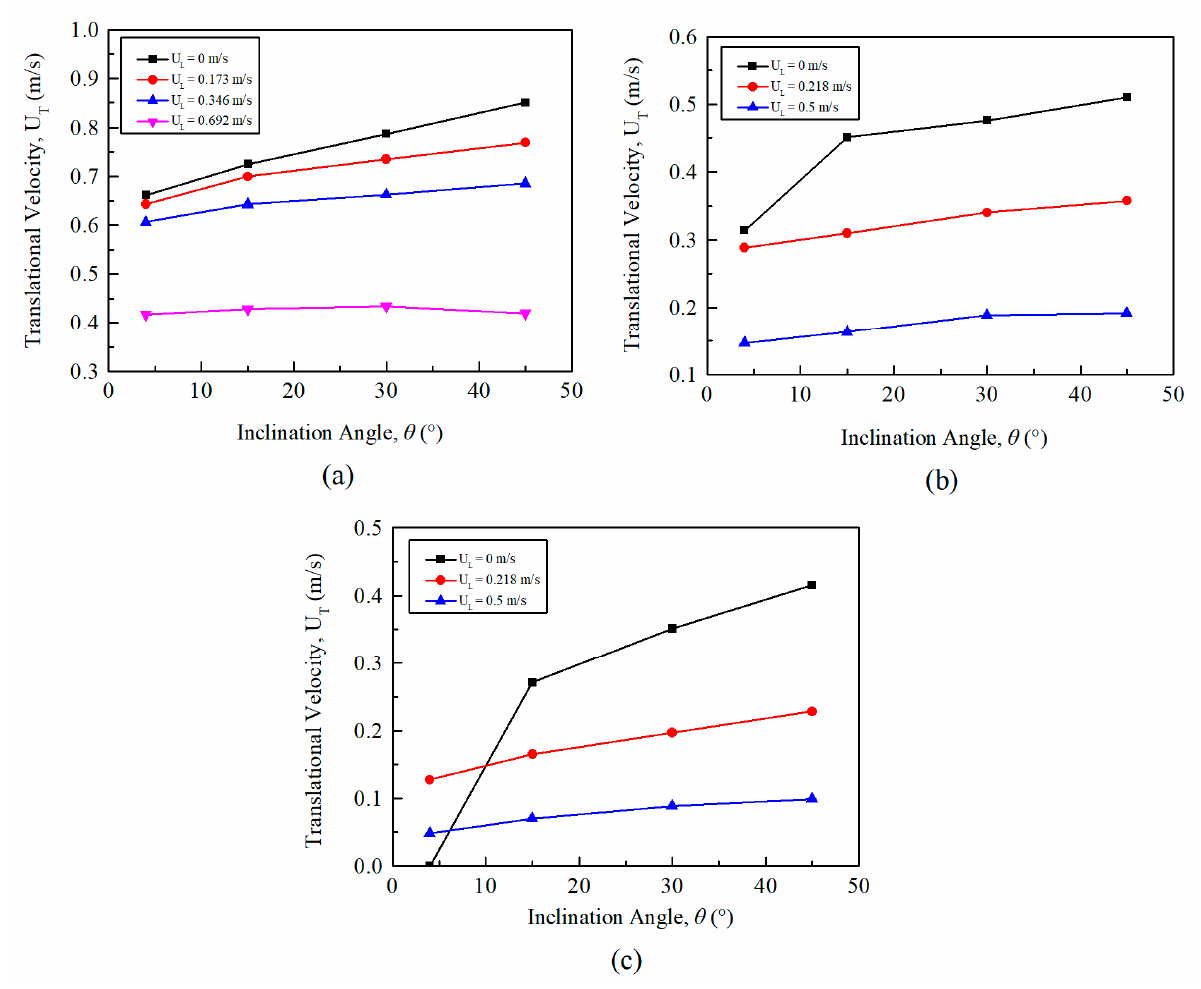
Figure 14. Influence of θ on U T . ( a ) Water; ( b ) 45 lb/bbl BW; ( c ) 48.5 lb/bbl BW.